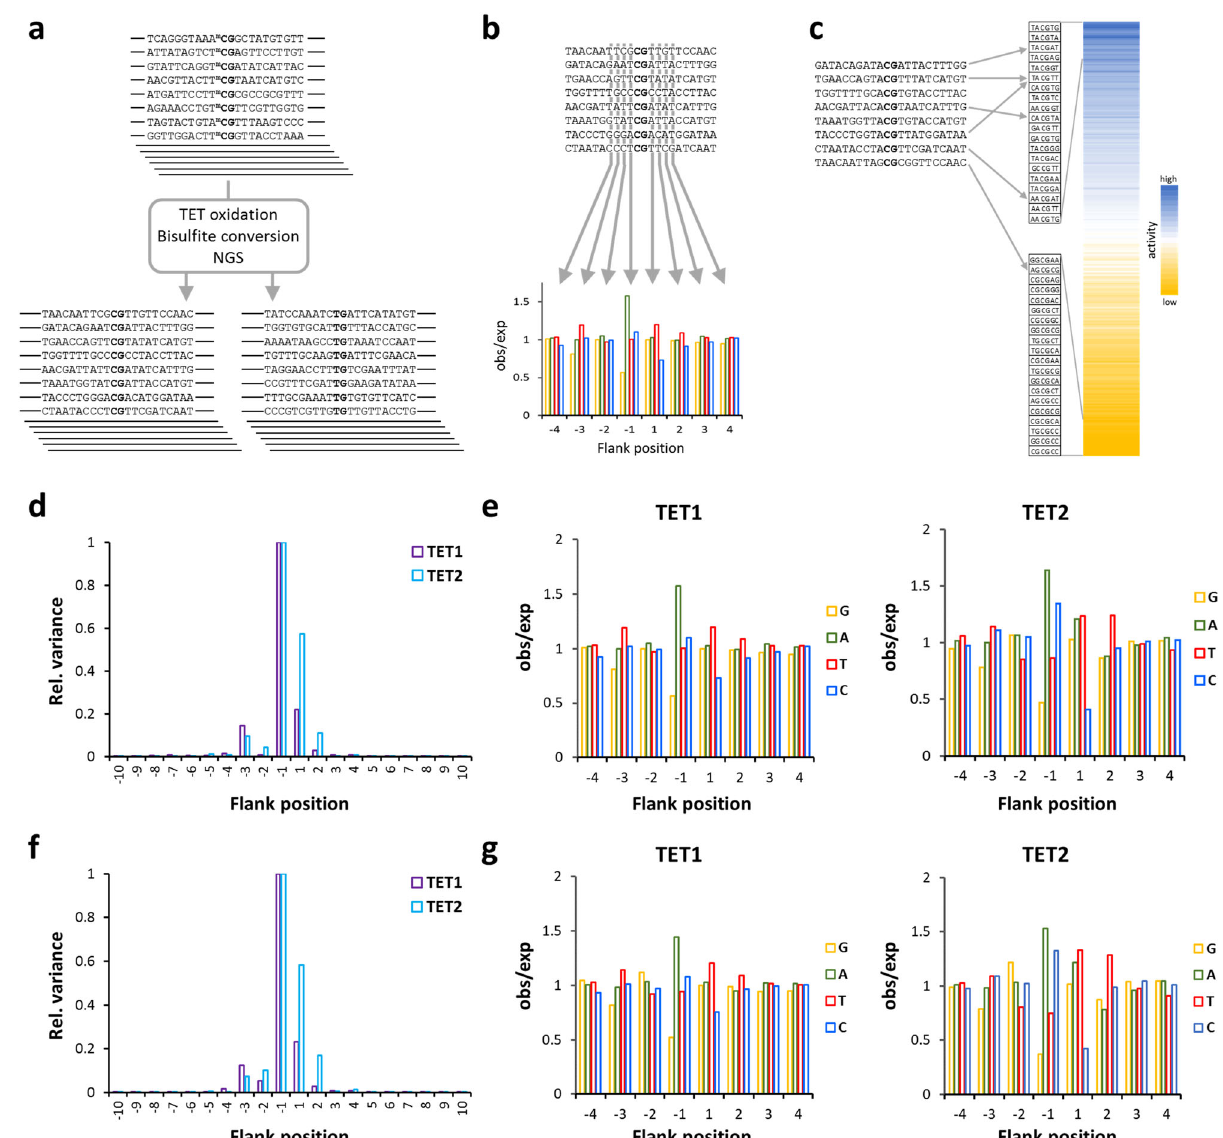
Fig. 1 Global analysis of fl anking sequence effects on mCpG and hmCpG oxidation by TET1 and TET2. a Principle of the Deep enzymology approach. Libraries of DNA sequences containing one target cytosine (here mCpG) in a randomized context of ten nucleotides on either side are oxidized by TET enzymes and subjected to bisul fi te conversion. By NGS the oxidation state and individual DNA sequences of single product molecules are determined (for details cf. Supplementary Fig. 1). b Principle of the fi rst step of the data analysis. At each fl anking position, the enrichment and depletion of individual bases in the methylated product pool is determined and expressed as observed/expected (obs/exp) values. c Principle of the second step of the data analysis. Methylation levels are averaged for all 256 NNCGNN sites, thereby revealing combinatorial fl anking sequence effects. d Position-speci fi c variance of oxidation of mCpG substrates. For the averaged TET1 and TET2 data sets, the sum of the (obs/exp -1)² values for G, A, T, and C were determined for all − 10 to + 10 fl ank positions and plotted after scaling to the largest value. The data show that the − 3 to + 2 fl ank positions have the largest in fl uence on the methylation rate. e Average mCpG oxidation levels of substrates containing speci fi c bases at − 4 to + 4 fl ank positions by TET1 and TET2. Oxidation levels are given as observed/expected (obs/exp) values. f , g Same as d and e , but referring to hmCpG